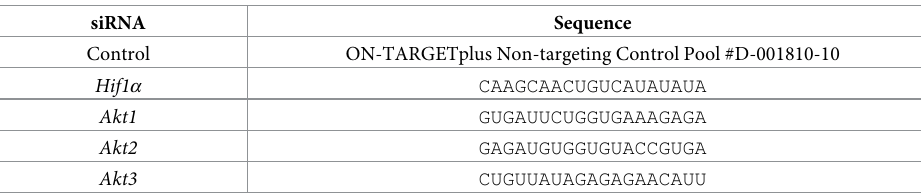
Table 2. Sequence of